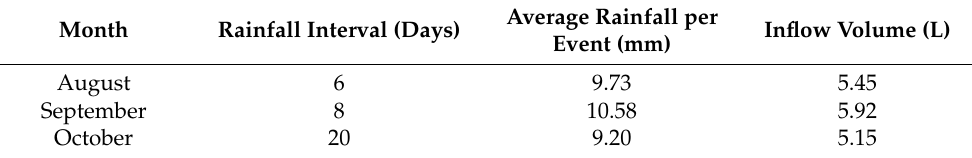
Table 3. Experimental water inflow parameters for August, September, and October.